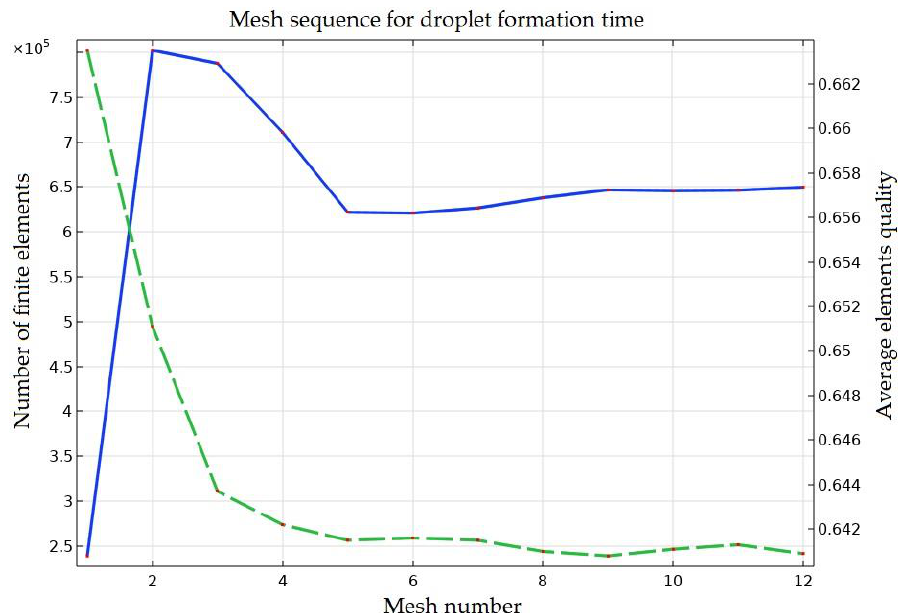
Figure 3. Representation of an adaptive mesh refinement sequence.